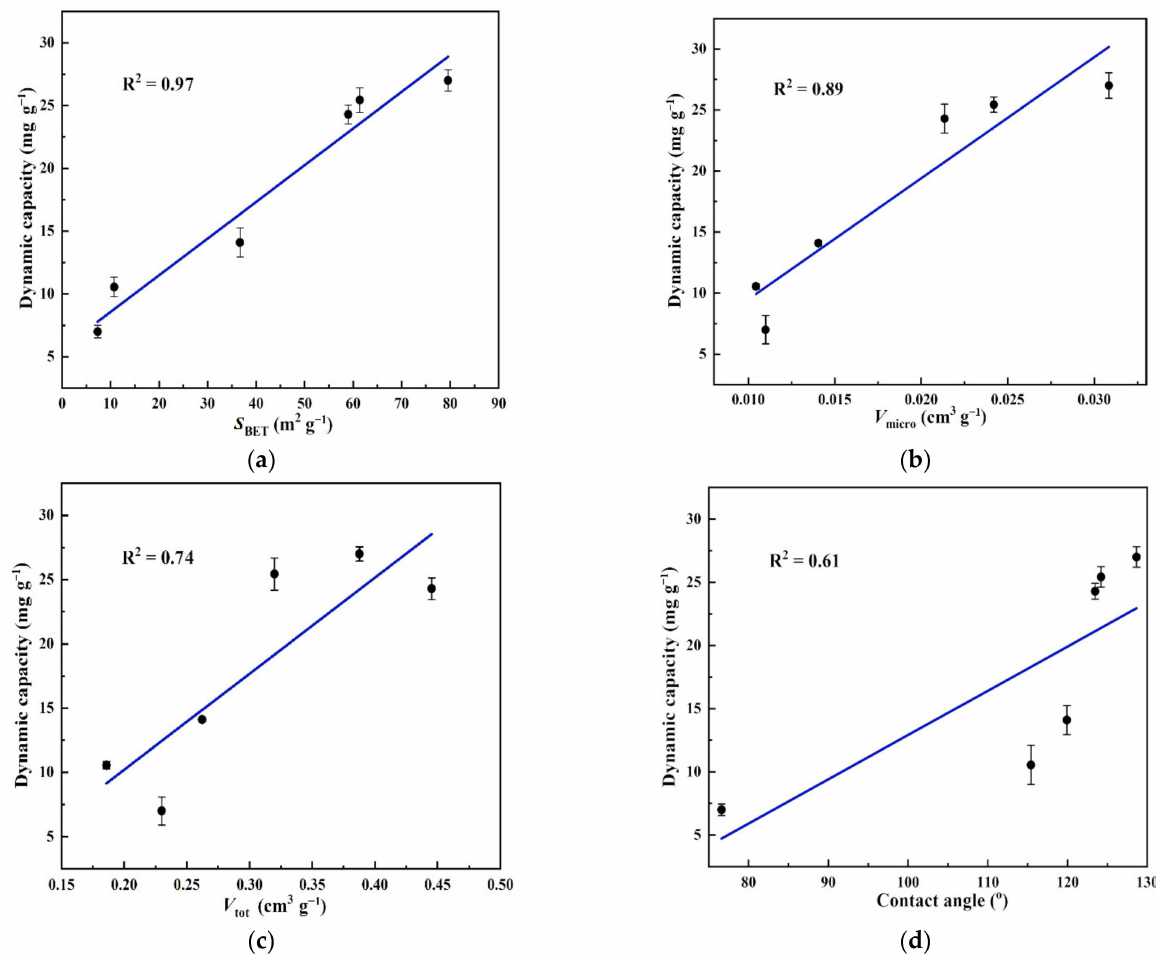
Figure 9. Relationships between Q B and S BET ( a ), Q B and V tot ( b ), Q B and V micro ( c ) and Q B and contact angle ( d ) for the six